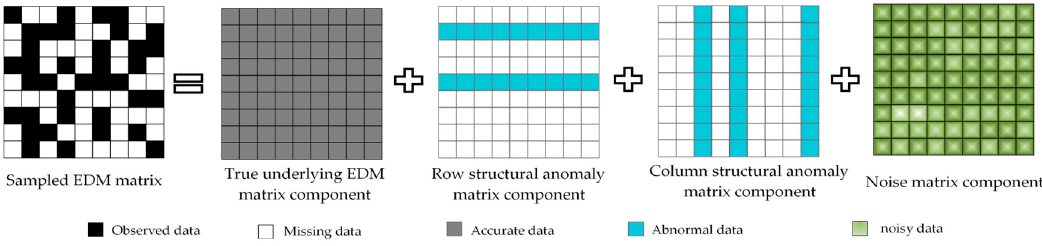
Figure 2. Illustration of the sampled Euclidean Distance Matrix (EDM) matrix.